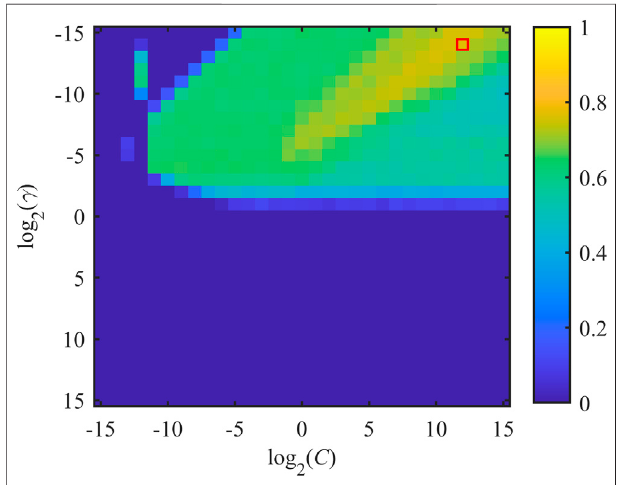
FIGURE 2 | Distribution of J as a function of misclassi fi cation cost C and SVM-RBFkernelparameter c . x -and y -axesareexpressedinlogarithmicunits for better interpretability of the adopted grid search. J opt is achieved by considering the pair ( C opt , c opt ), which is indicated by the red